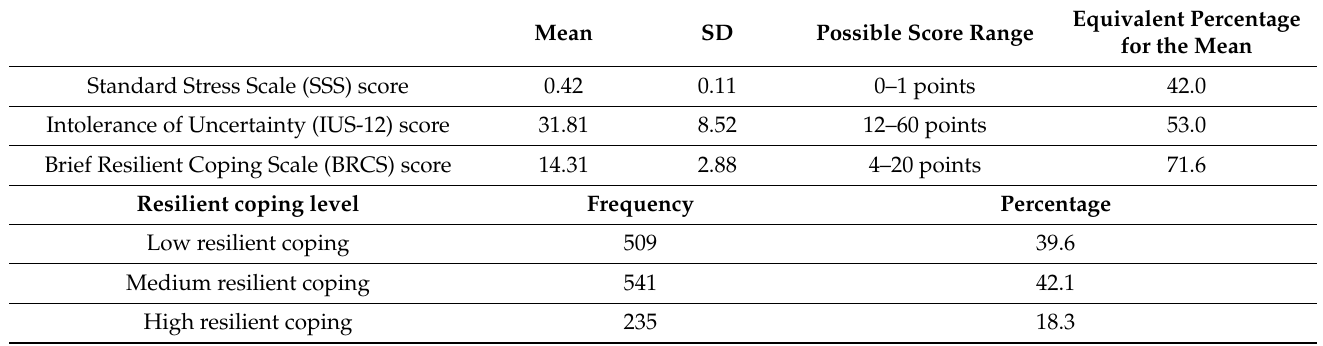
Table 3. Descriptive analysis of the HCWs’ stress, resilient coping, and intolerance of uncertainty.